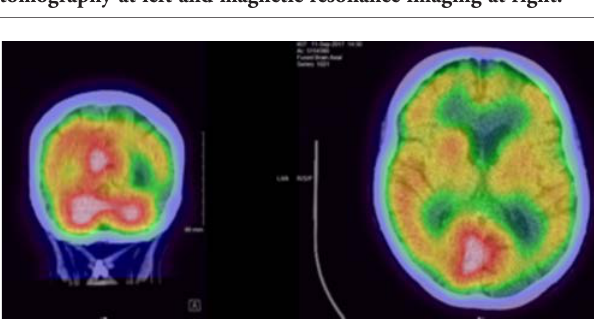
Figure 2. Left occipital cortex atrophy evident on computed tomography at left and magnetic resonance imaging at right.